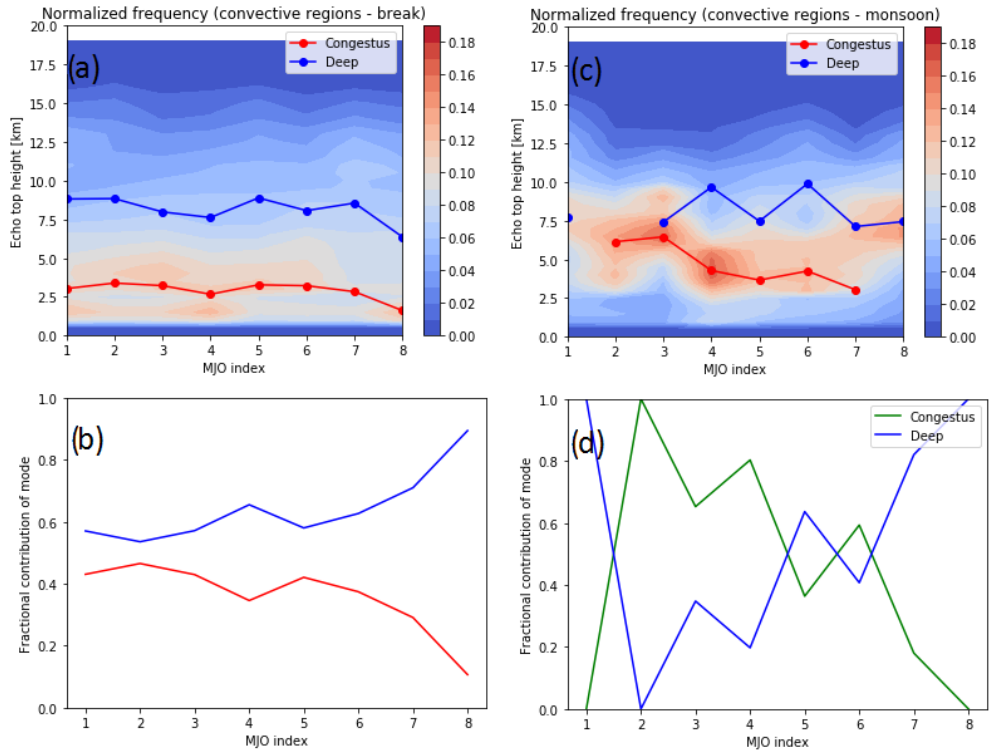
Figure 8. (a) normalized frequency distribution of ETHs in convective regions for given MJO indices in break conditions. The color shading represents the normalized frequency. The red line is the location of the congestus mode, and the blue line is the location of the deep convective mode. (b) fractional contribution of each mode ( A ) to normalized frequency distributions in (a) . (c, d) as in (a, b) , but for monsoon